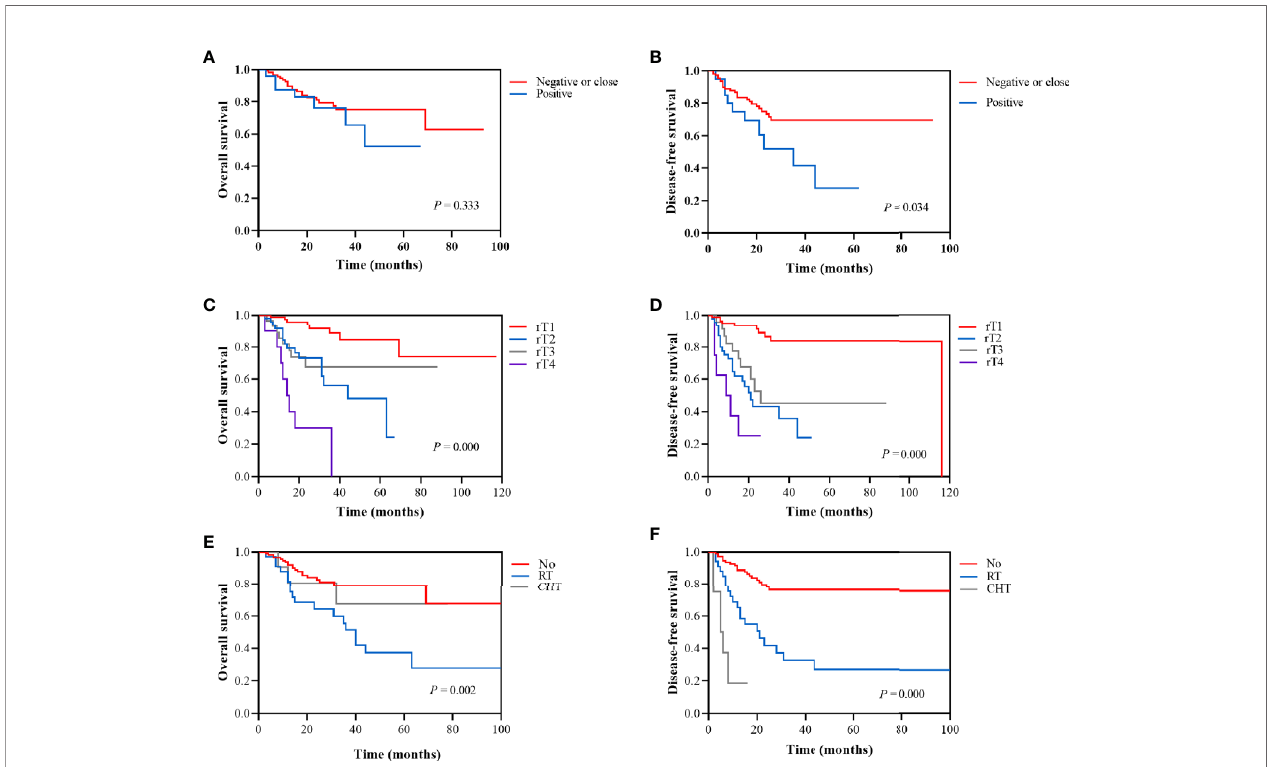
FIGURE 4 | Kaplan-Meier survival analysis according to margin status (negative or close vs positive): (A) 2-year OS was 81.0% vs 76.2%. (B) 2-year DFS was 73.3% vs 52.0%. Kaplan-Meier survival analysis according to recurrent T stage (rT1, rT2, rT3, and rT4): (C) 2-year OS was 93.7%, 73.1%, 67.6%, and 30.0%, respectively. (D) 2-year DFS was 93.3%, 43.1%, 52.5%, and 25.0%, respectively. Kaplan-Meier survival analysis according to adjuvant therapy (No, RT, and CHT): (E) 2-year OS was 82.6%, 64.1%, and 80.8%, respectively. (F) 1-year DFS was 88.7%, 65.3%, and 16.7%, respectively.